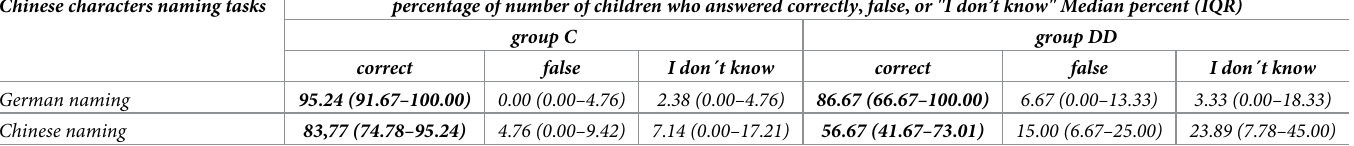
Table 3. Error rate.